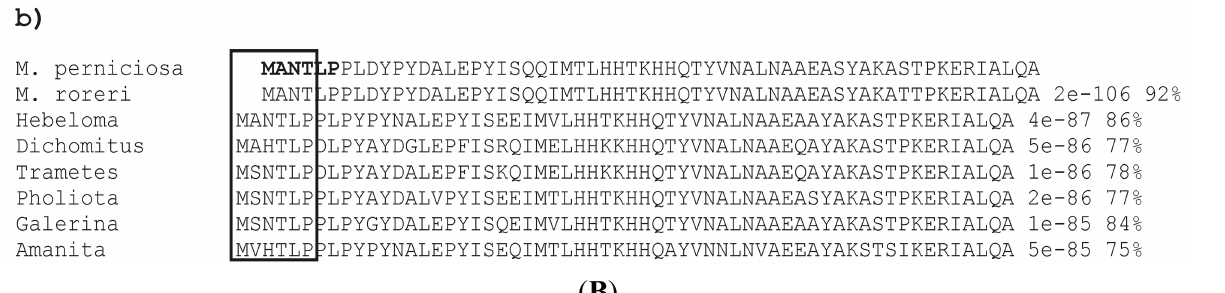
its protein sequence. ( a ) Highlighted are upstream a region defined as sequence of start and stop codon (marked in bold letters). The highlighted gray sequence is the CDS (codon DNA sequence); ( b ) Highlighted are upstream region with the following sequence of aminoacids MANTLP (methionine, adenine, asparagine, threonine, leucine, proline) in basidiomycete fungi marked in bold letters from M. perniciosa and in a box frame from other